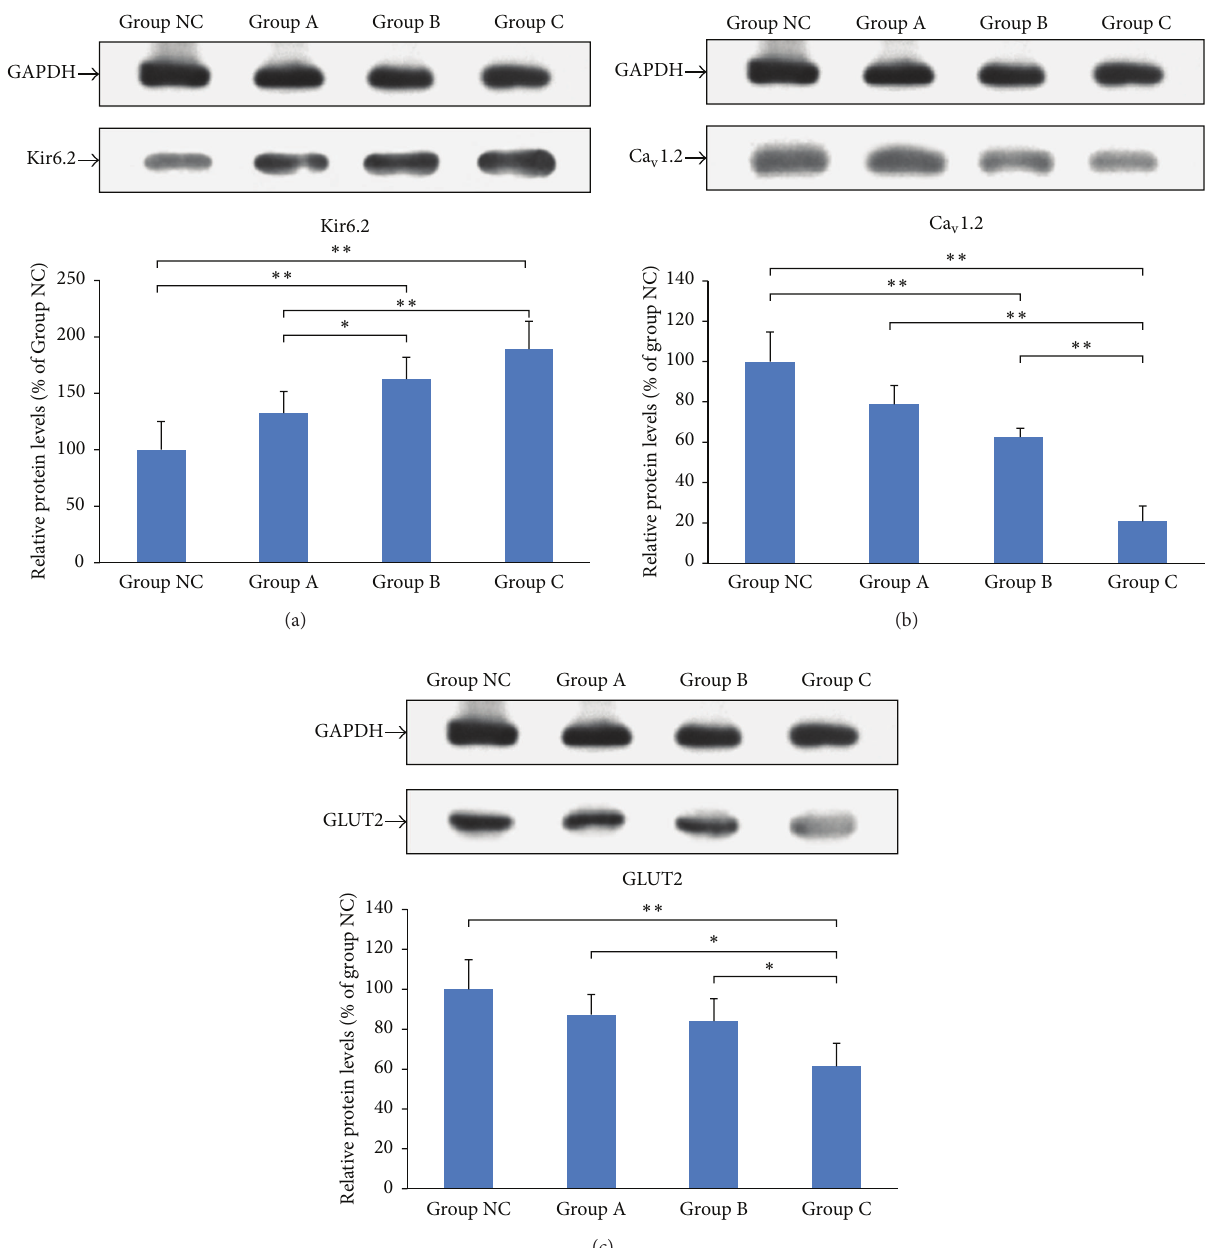
Figure 5: Effects of simvastatin on protein levels of Kir6.2 (a), Ca v 1.2 (b), and GLUT2 (c) in MIN6 cells. ∗ 𝑃 < 0.05 and ∗∗ 𝑃 < 0.01 .